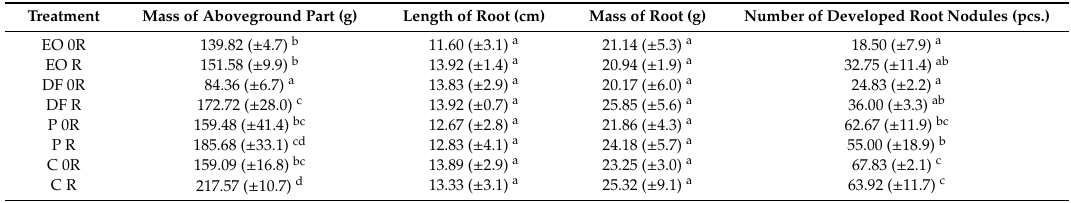
Table2. Thee ff ectofpetroleum-derivedsubstancesandbioremediationonmorphologicalcharacteristics of Vicia faba L. The values are expressed per plant.